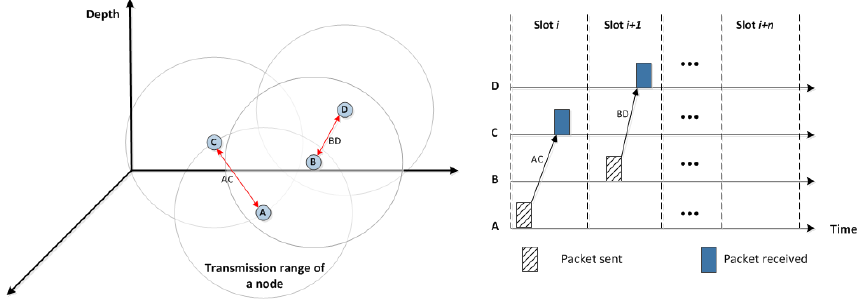
Figure 3. An example of exposed terminal